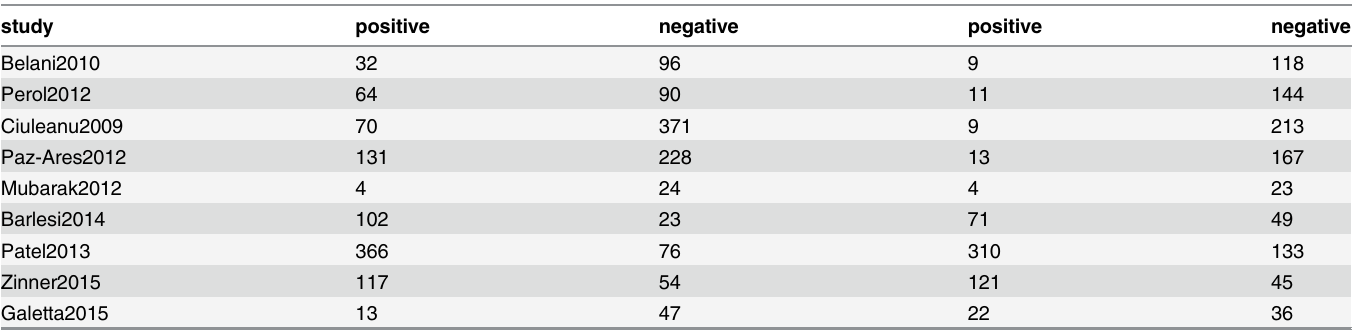
Table 2. The incidence of grade 3 – 4 AEs.